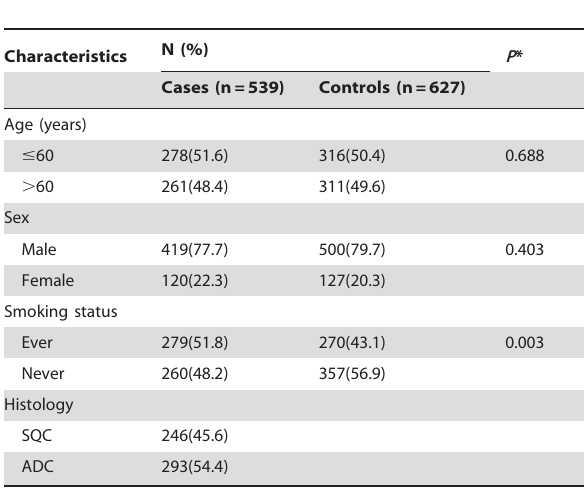
Table 1. Selected characteristics of non-small-cell lung cancer cases and